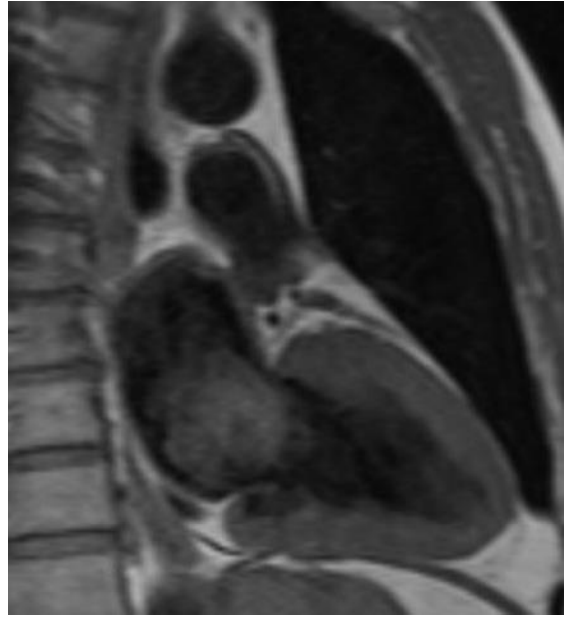
Figure 3. Magnetic resonance imaging of a left atrial